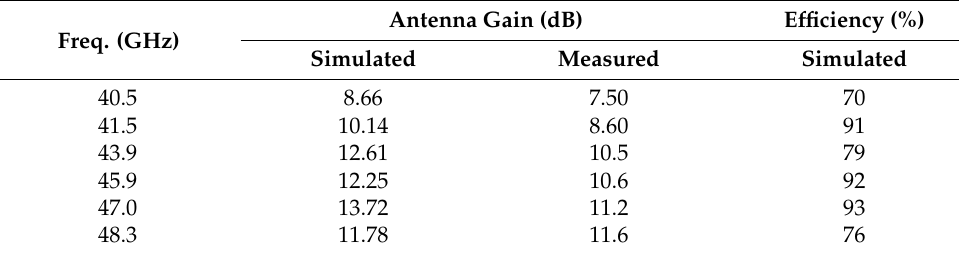
Figure 5. Measured radiation pattern of the proposed array antenna. Table 3. Gain and efficiency of the proposed array antenna at different frequencies. Antenna Gain (dB) Efficiency (%) Freq. (GHz) Simulated Measured